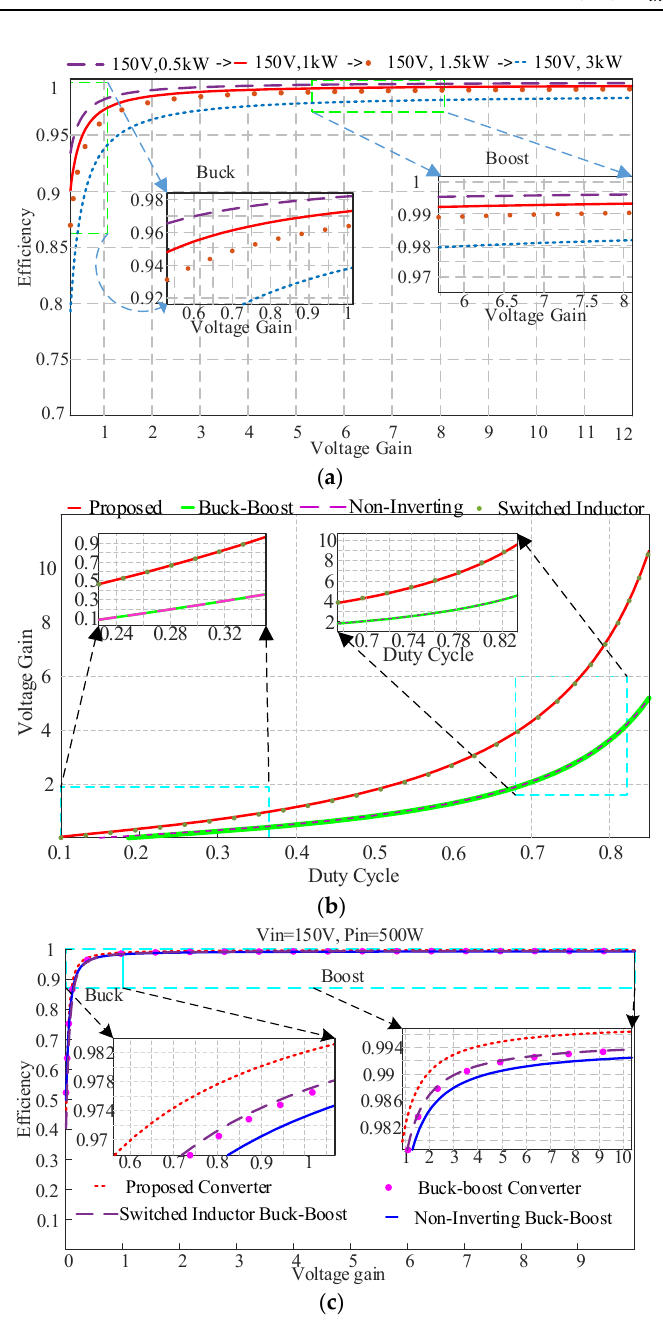
Figure 10. ( a ) Converter efficiency at fixed input voltage and different loading, ( b ) voltage gain comparison among the proposed and other buck-boost converters, and ( c ) efficiency comparison among the proposed and other buck-boost converters. Table 1. Voltage gain and component stress comparison.